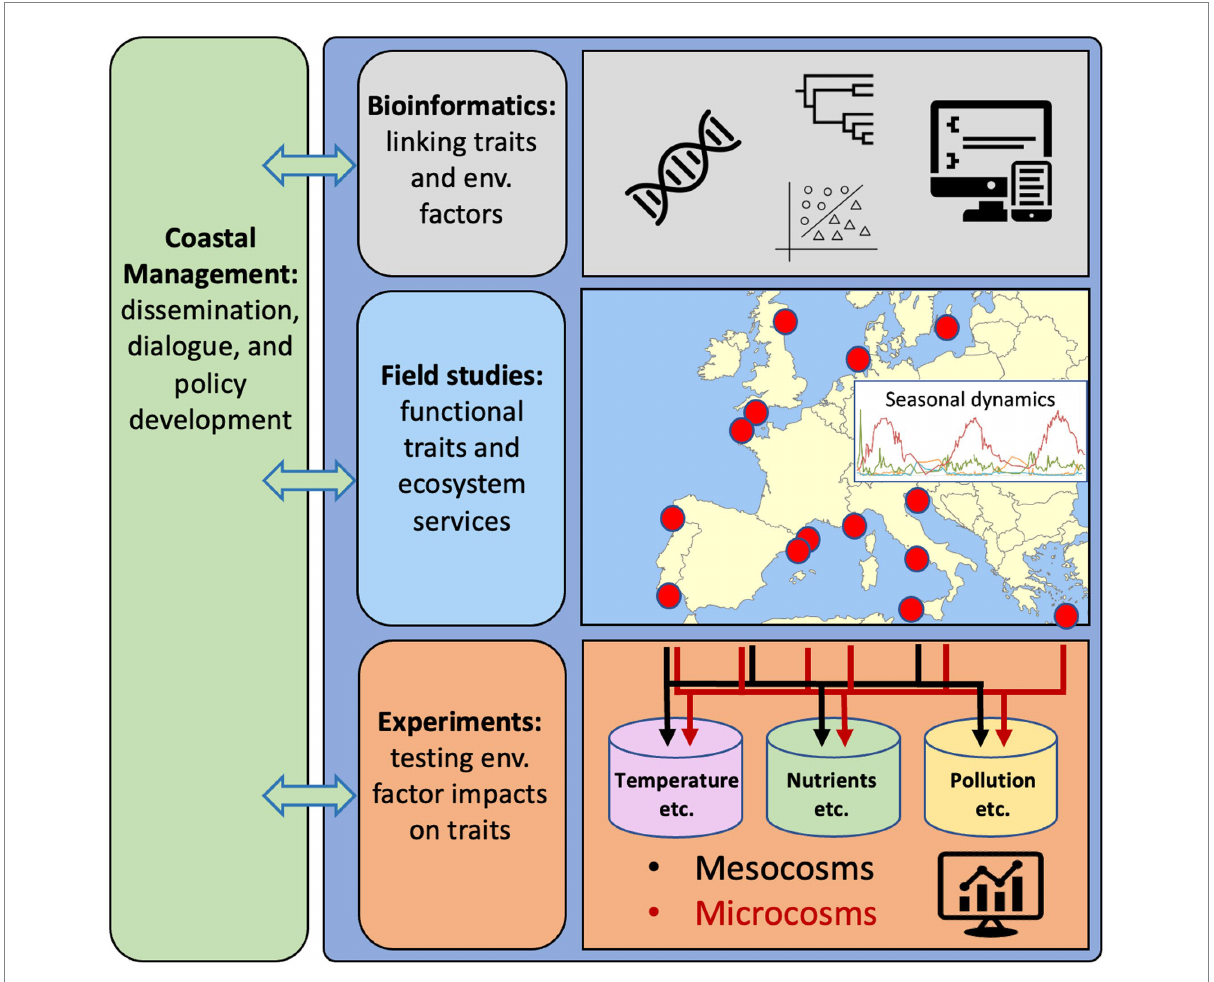
FIGURE 2 Research strategy to obtain comprehensive understanding of the genetic responses of key marine bacteria to environmental stressors in coastal waters, using European waters as an example. Bioinformatics for developing computational tools and workflows to effectively interpret linkages between functional traits and environmental factors. Field studies to generate and evaluate data on traits of key bacterial populations (from genomes and transcriptomes) and their distributions in time and space in relation to variability in environmental conditions. Experiments to identify and confirm relationships between environmental factors and specific traits and bacterial populations. Synergies between computational analyses of genomics, distributions and measured variability in environmental variables from field studies and experiments are essential to identify how bacterial functional traits can form the basis for genetic counselling of coastal seas. Dialogs with societal actors through all steps in the research strategy will be needed for reaching the goal of using bacteria to improve the quality of actions in coastal